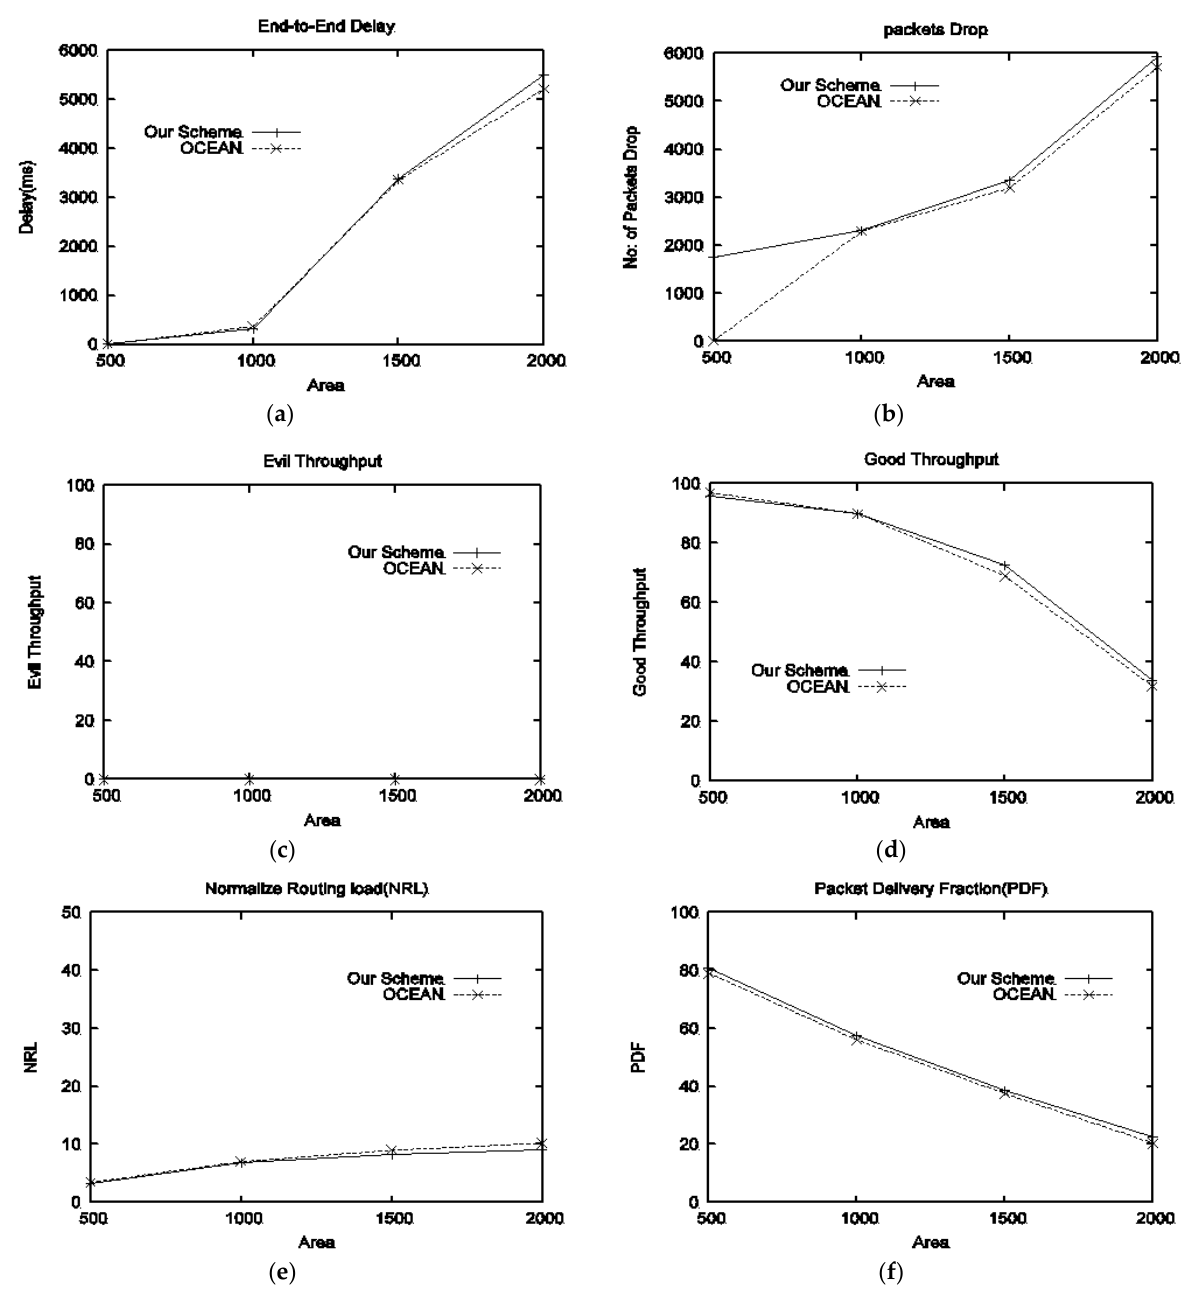
Figure 3. Performance of proposed scheme with respect to different sizes of the area against type-II attackers: ( a ) delay vs.